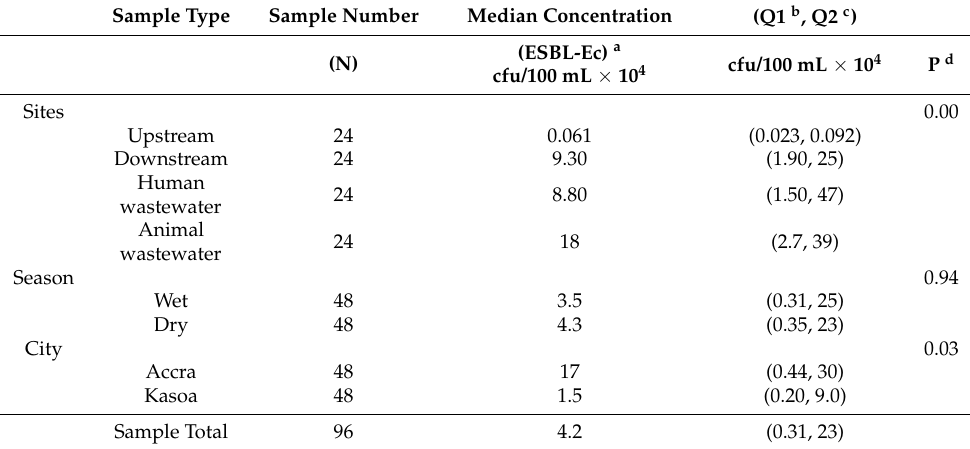
Table 3. Concentrations of ESBL-Ec a , stratified by site, city and season of water samples